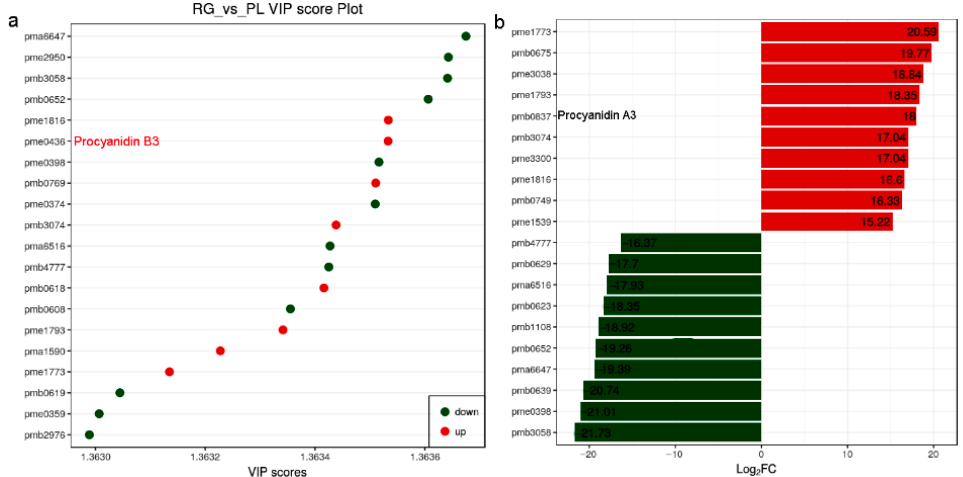
Figure 3. Metabolites with a VIP value greater than 1.363 and the distribution of differential metabolites with a multiple of 15 times or more, and in T. hemsleyanum . ( a ) Variable importance in projection (VIP) value (>1.363) used to screen differential metabolites. It is generally believed that variables satisfying both p < 0.05 and VIP > 1.0 are differential metabolites; ( b ) After qualitative and quantitative analysis of the detected metabolites, combined with the grouping of specific samples, compare the fold change of the quantitative information of metabolites in each group (log2FC > 15).